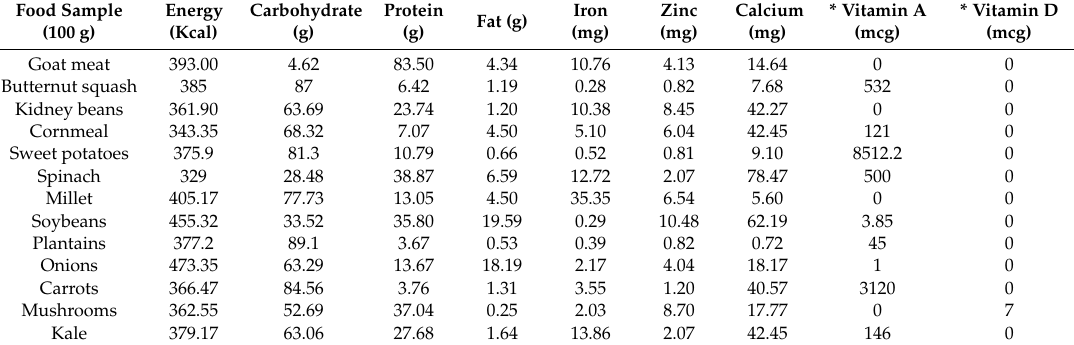
Table 3. Results obtained from chemical analysis of food samples sourced from Lubbock, TX, USA. Food Sample (100 g) Goat